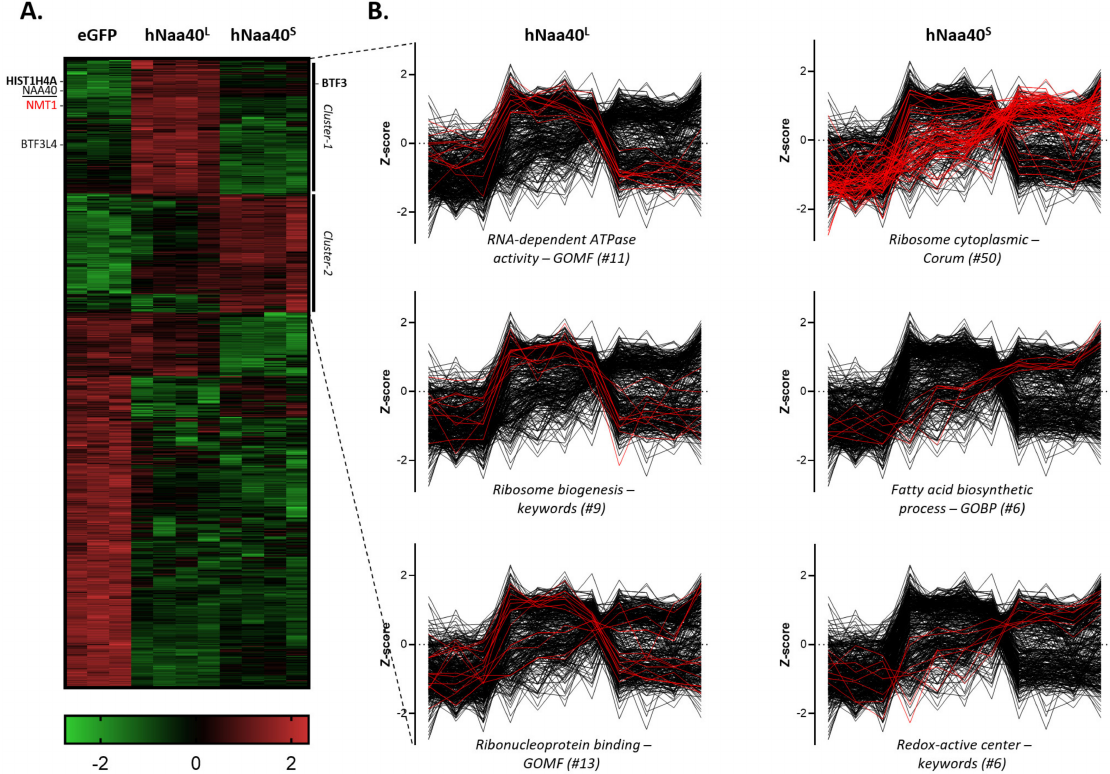
Figure 10. Proximity-dependent biotin identification (BiolD) enables the discovery of differential hNaa40p proteoform interactors. ( A ) Heat map representation of cluster analysis after ANOVA. The intensities of proteins with significantly different abundance ( p ≤ 0.01) in the respective interactomes (#937) are represented. Two clusters (cluster 1 and 2) enriched for hNaa40 L and Naa40 S interactors can be observed. Green indicates low intensities while red indicates high intensities. ( B ) Profile plots of representative protein categories with significant increased abundance (false discovery rate (FDR) < 2%) in the hNaa40 L(dTIS>CTC) (middle panel) and hNaa40 S (right panel) setups are shown for the two indicated clusters (see also Table S1) across all replicate samples and setups